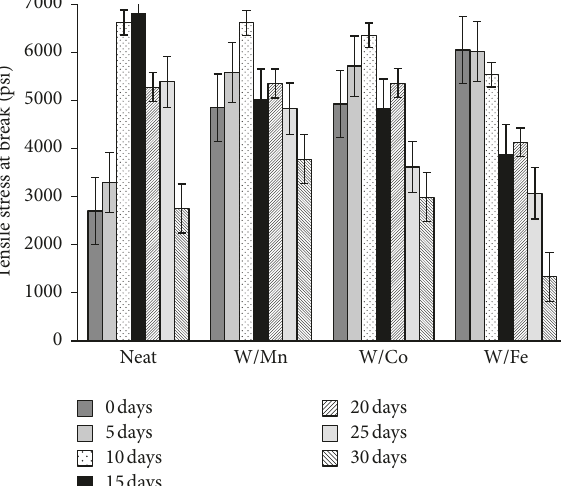
Figure 14: Elongation at break of Apel 6509 COC neat and formulated films with different POA.